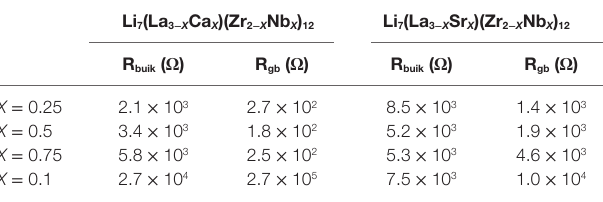
TaBle 1 | r bulk and r gb values of the a-llZnb (a = sr or ca, X = 0.25, 0.5, 0.75, or 0.1)